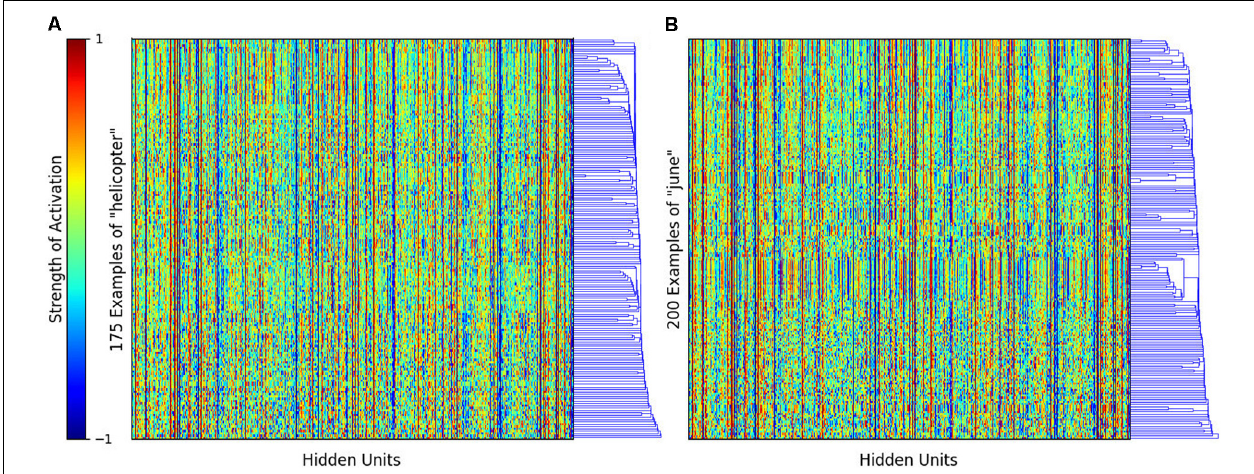
FIGURE 2 | Heatmap showing the SRN hidden unit activations for the word (A) helicopter and (B) june . The rows represent the different occurrences of the word in the corpus, and the columns represent the 512 different hidden units. The rows are hierarchically clustered such that rows that are more similar are located together more closely.